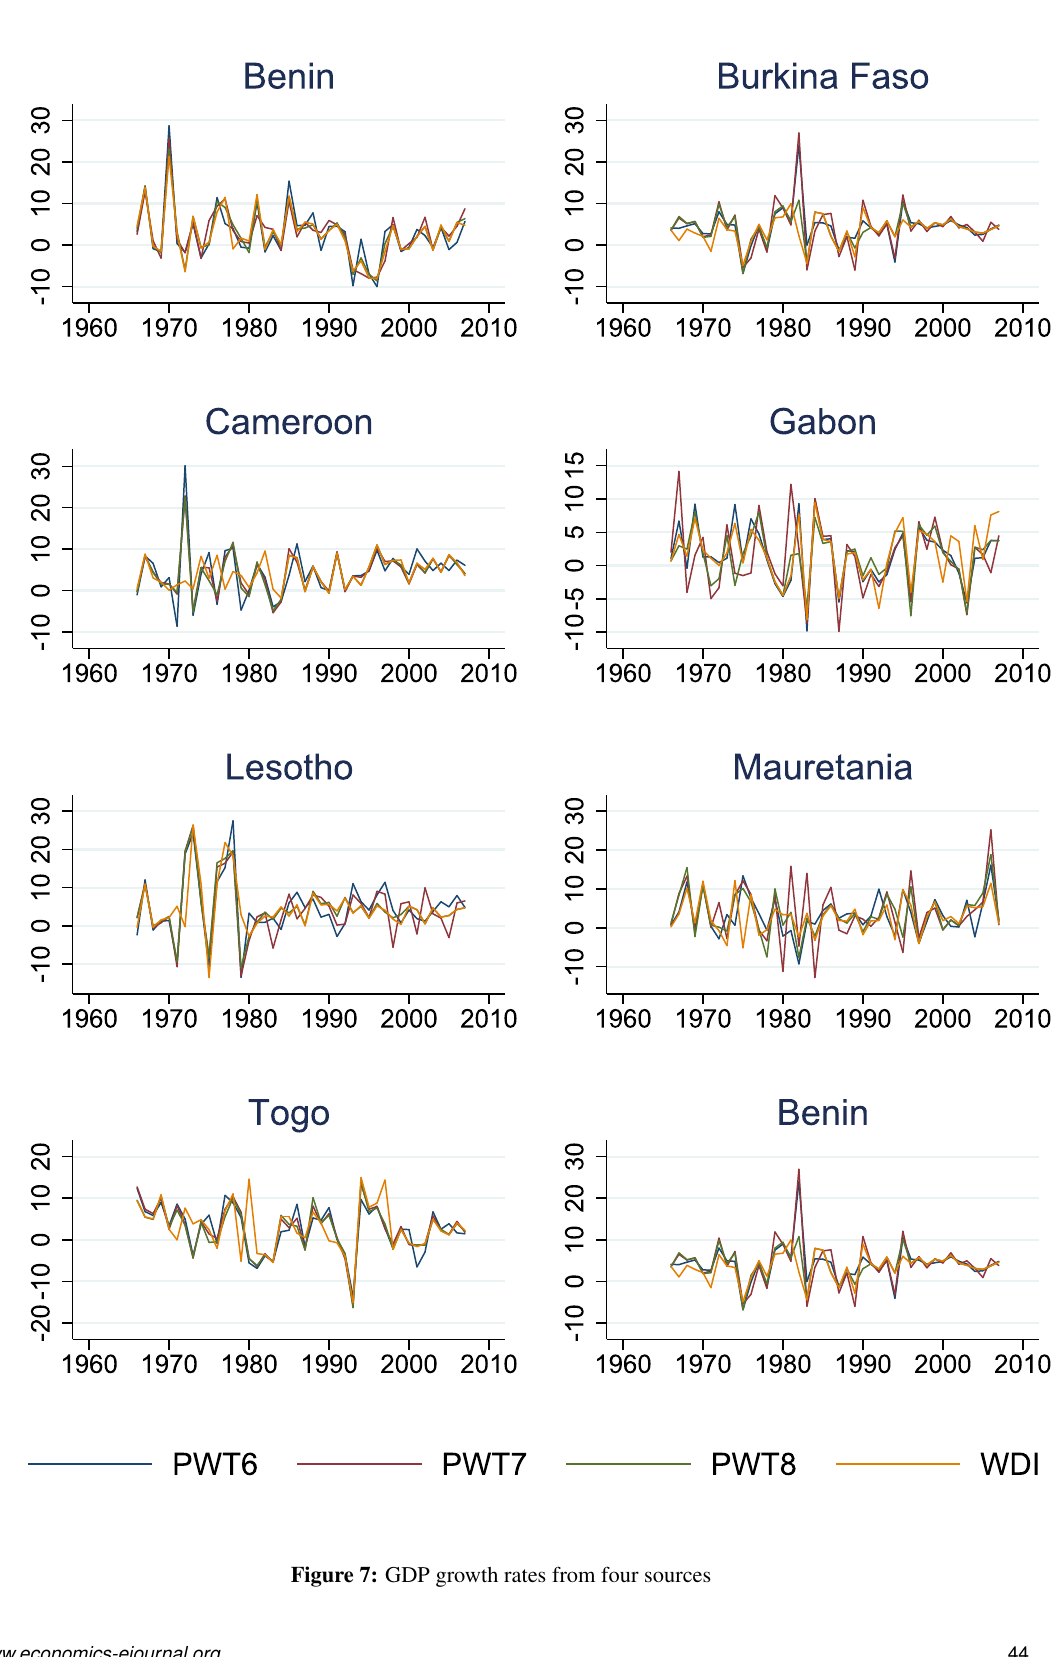
Figure 7: GDP growth rates from four